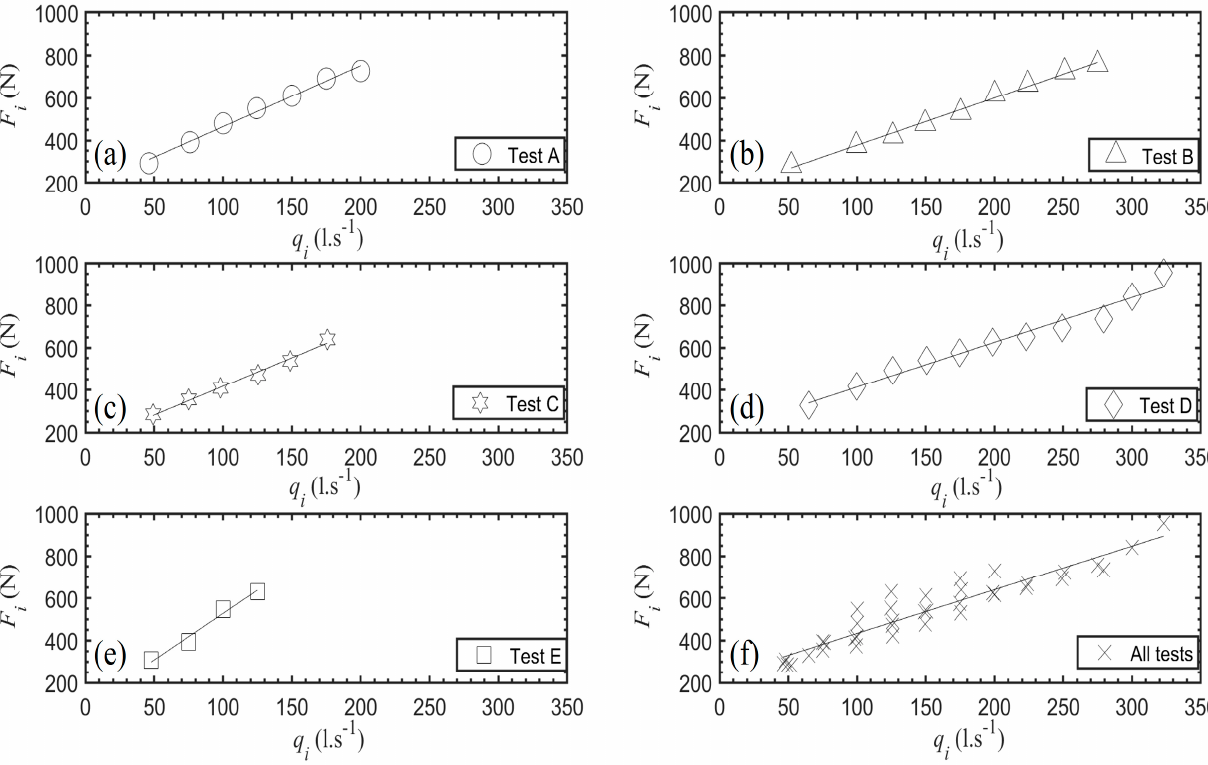
Figure 6. Axial load at the toe section during overtopping event for each of the five tests ( a–e ) and for all the tests ( f ) according to discharge values.